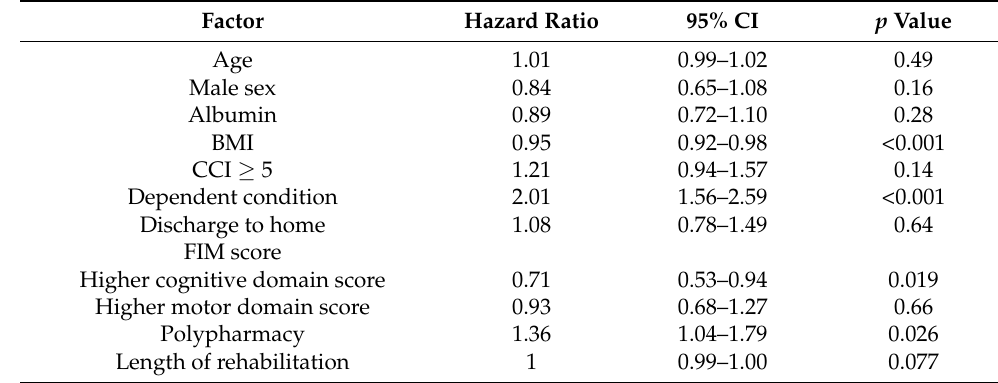
Table 3. Results of the Cox regression model for hospital readmission.